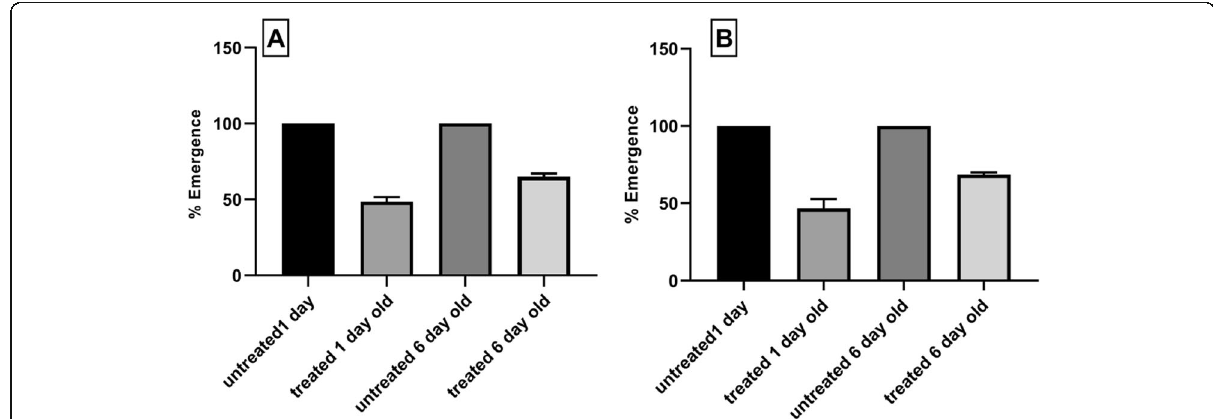
Fig. 3 Mortality percentage (means + SE) of Ceratitis capitata pupae treated with Beauveria bassiana suspension at 10 7